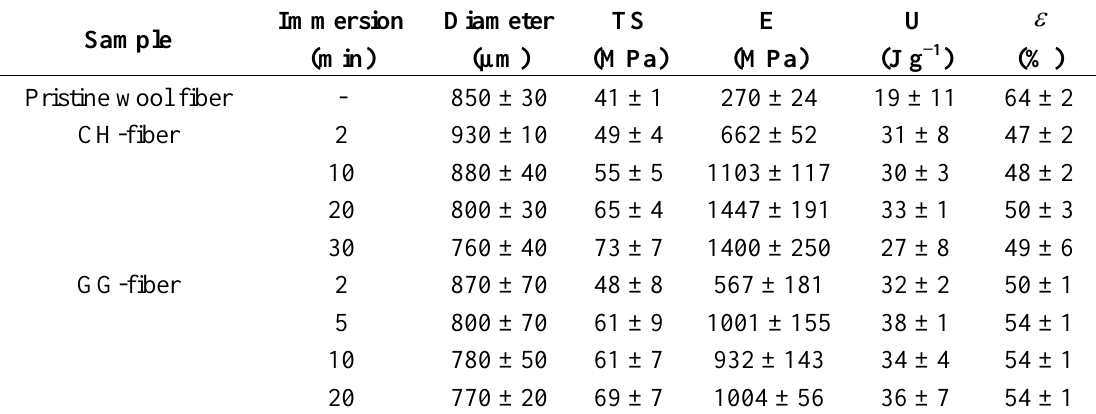
Table 1. Mechanical properties of CH-fiber and GG-fiber at different immersion duration times. Tensile strength (TS), Young’s modulus (E), work of extension (U) and extension (ε) for different single-treated fiber are